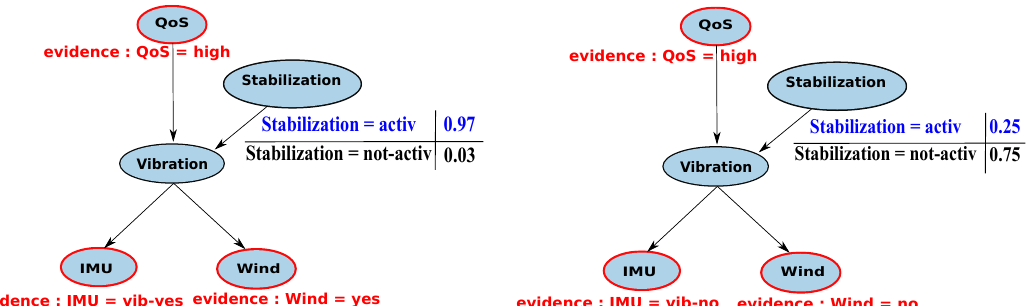
Figure 4. The probability to activate is the stabilization to maintain a good QoS of the application depending on the evidence on IMU and wind.